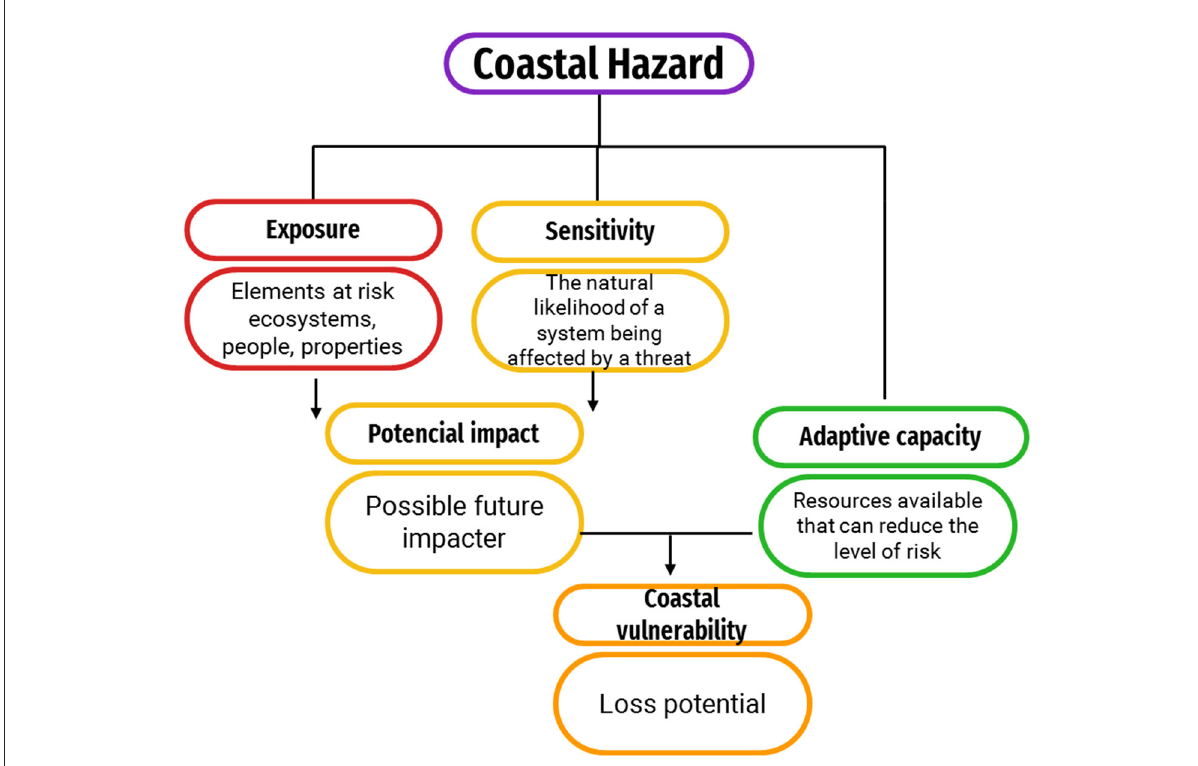
FIGURE1 Conceptual framework and terms related to coastal vulnerability [Source: Developed from Wamsley et al.